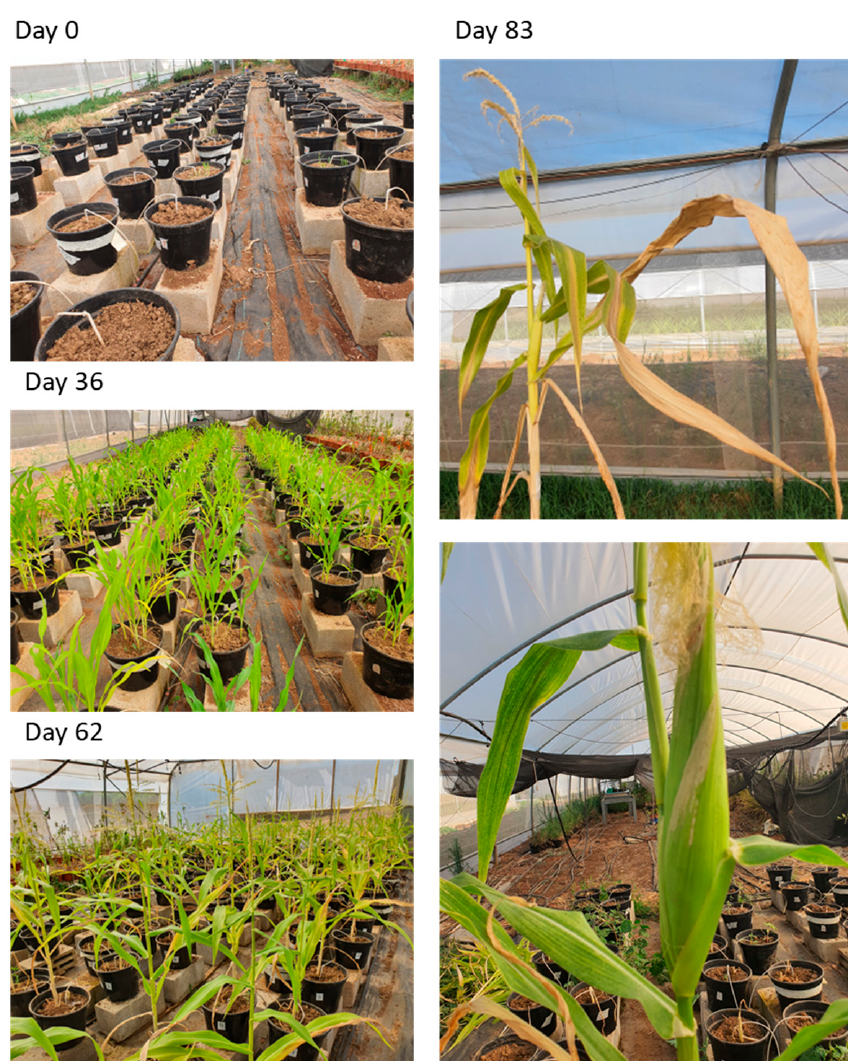
Figure 4. Photos of the net house experiment , which was performed in late wilt-susceptible Megaton cv. The male flowering was documented at 53 DAS. Disease symptoms were already clearly visible from day 62 onwards.